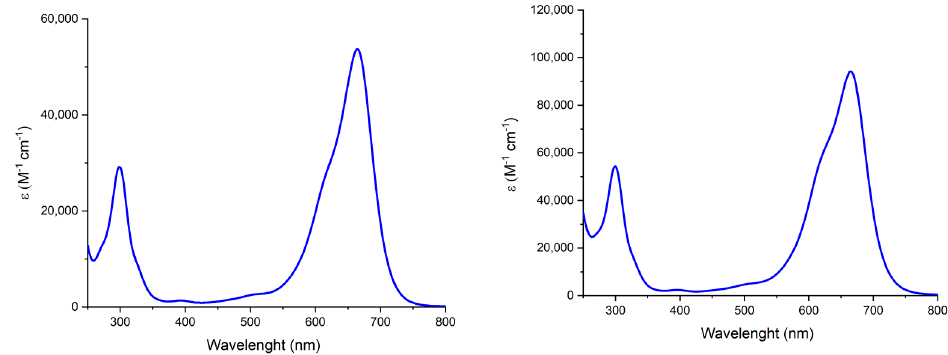
Figure 2. UV-vis absorption spectra of 2 ⋅ 10 − 5 M solution of 3 in H 2 O (left) and in 1M NaCl solution (right).